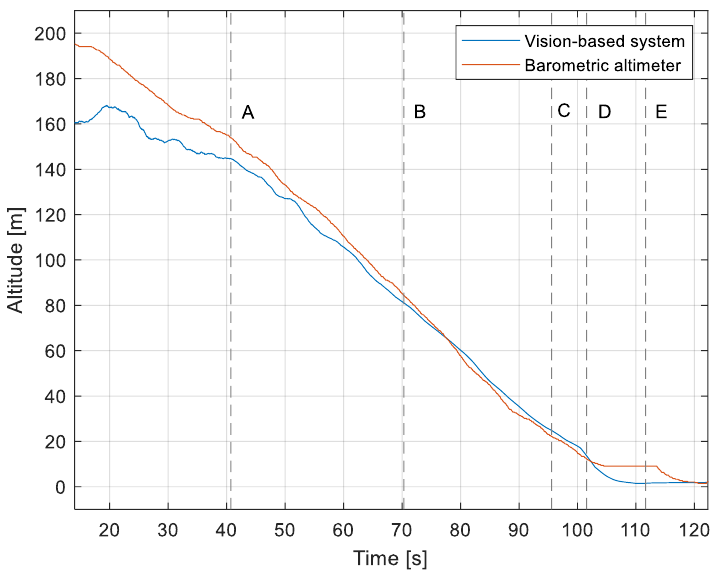
Figure 8. Altitude relative to the airside: Flight no. 1 (markers A–E correspond to the moment of recording the images in Figure 9).